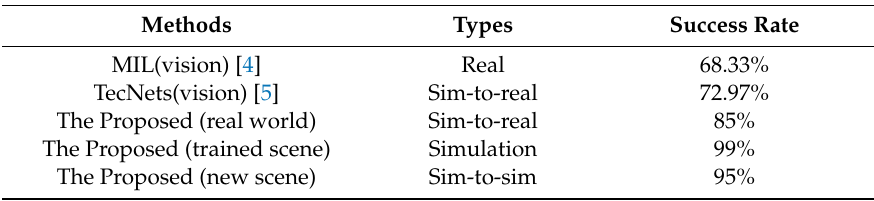
Figure 13. The experimental platform in the real world. Table 4. The result of different methods.